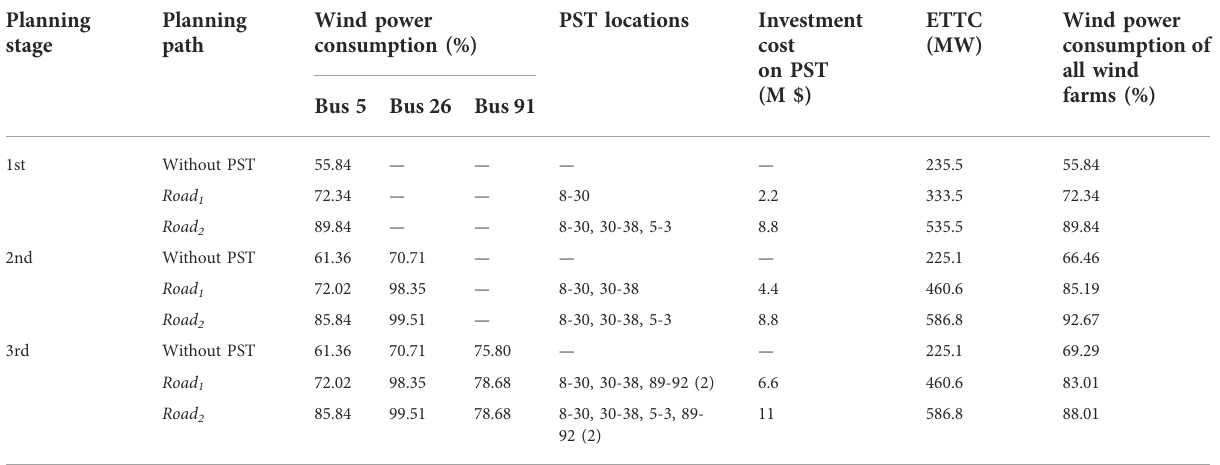
TABLE 2 IEEE 118-bus system results for different planning paths of PST. Planning